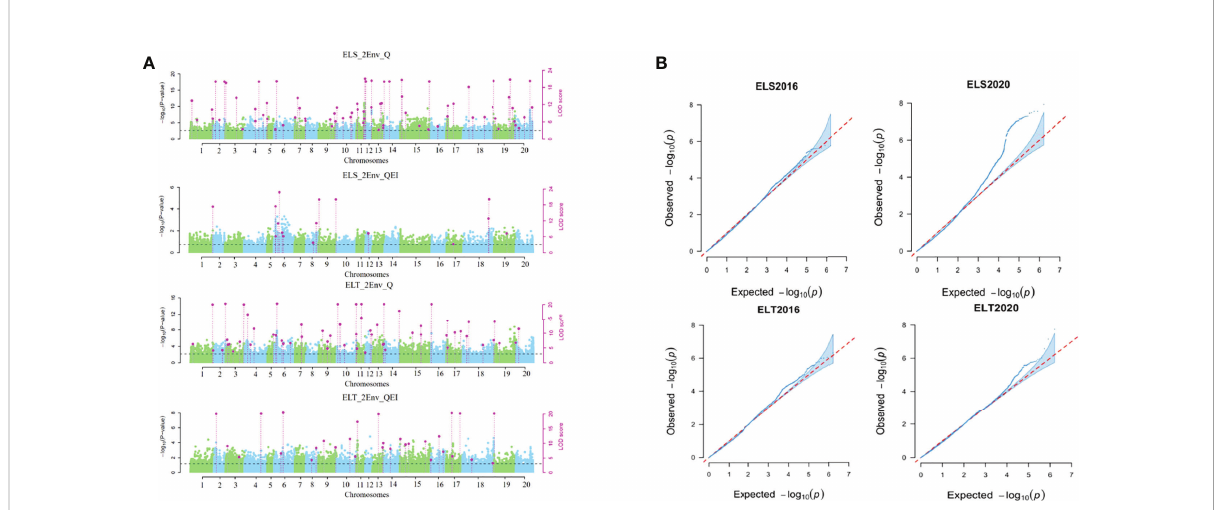
FIGURE 6 Results of association mapping of soybean epicotyl length traits. (A) Manhattan plot of locus distribution; (B) phenotype fi tting